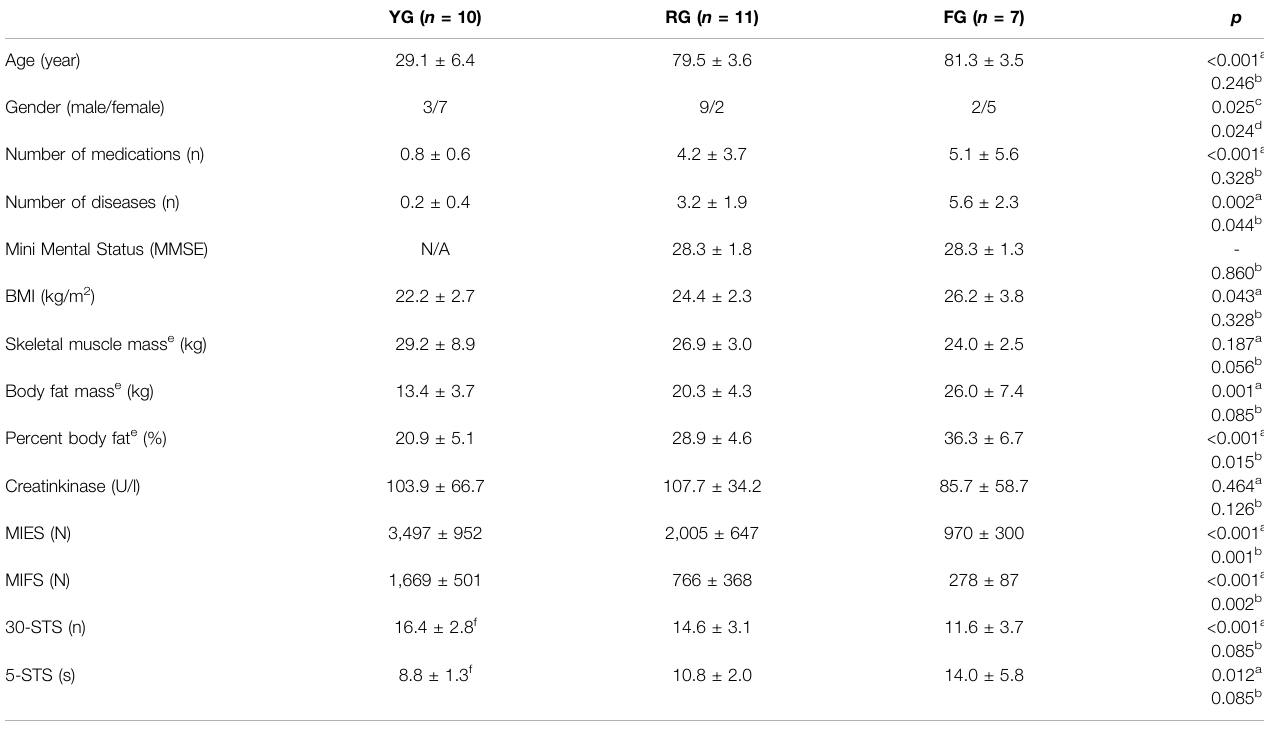
TABLE 2 | Baseline Characteristics of the three study